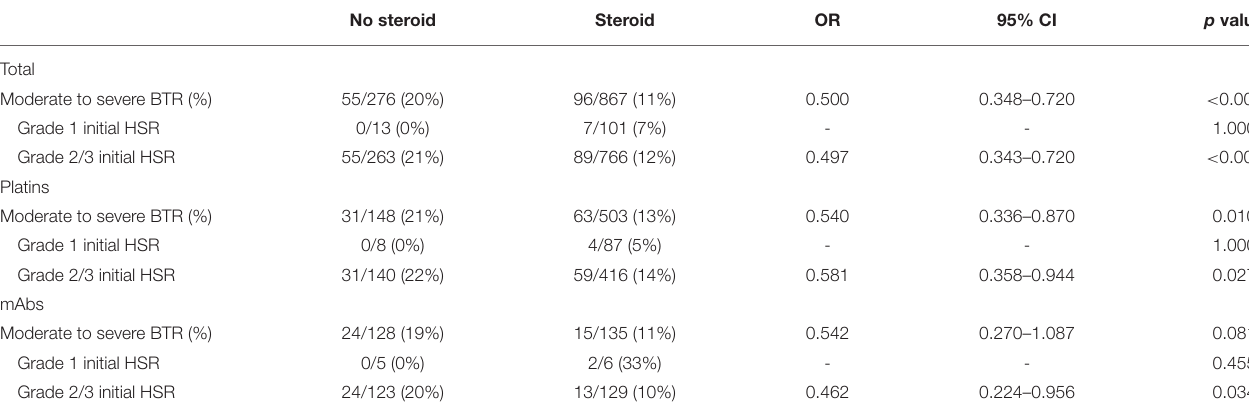
TABLE 5 | The association of moderate to severe BTR occurrence and steroid administration according to the severity of initial